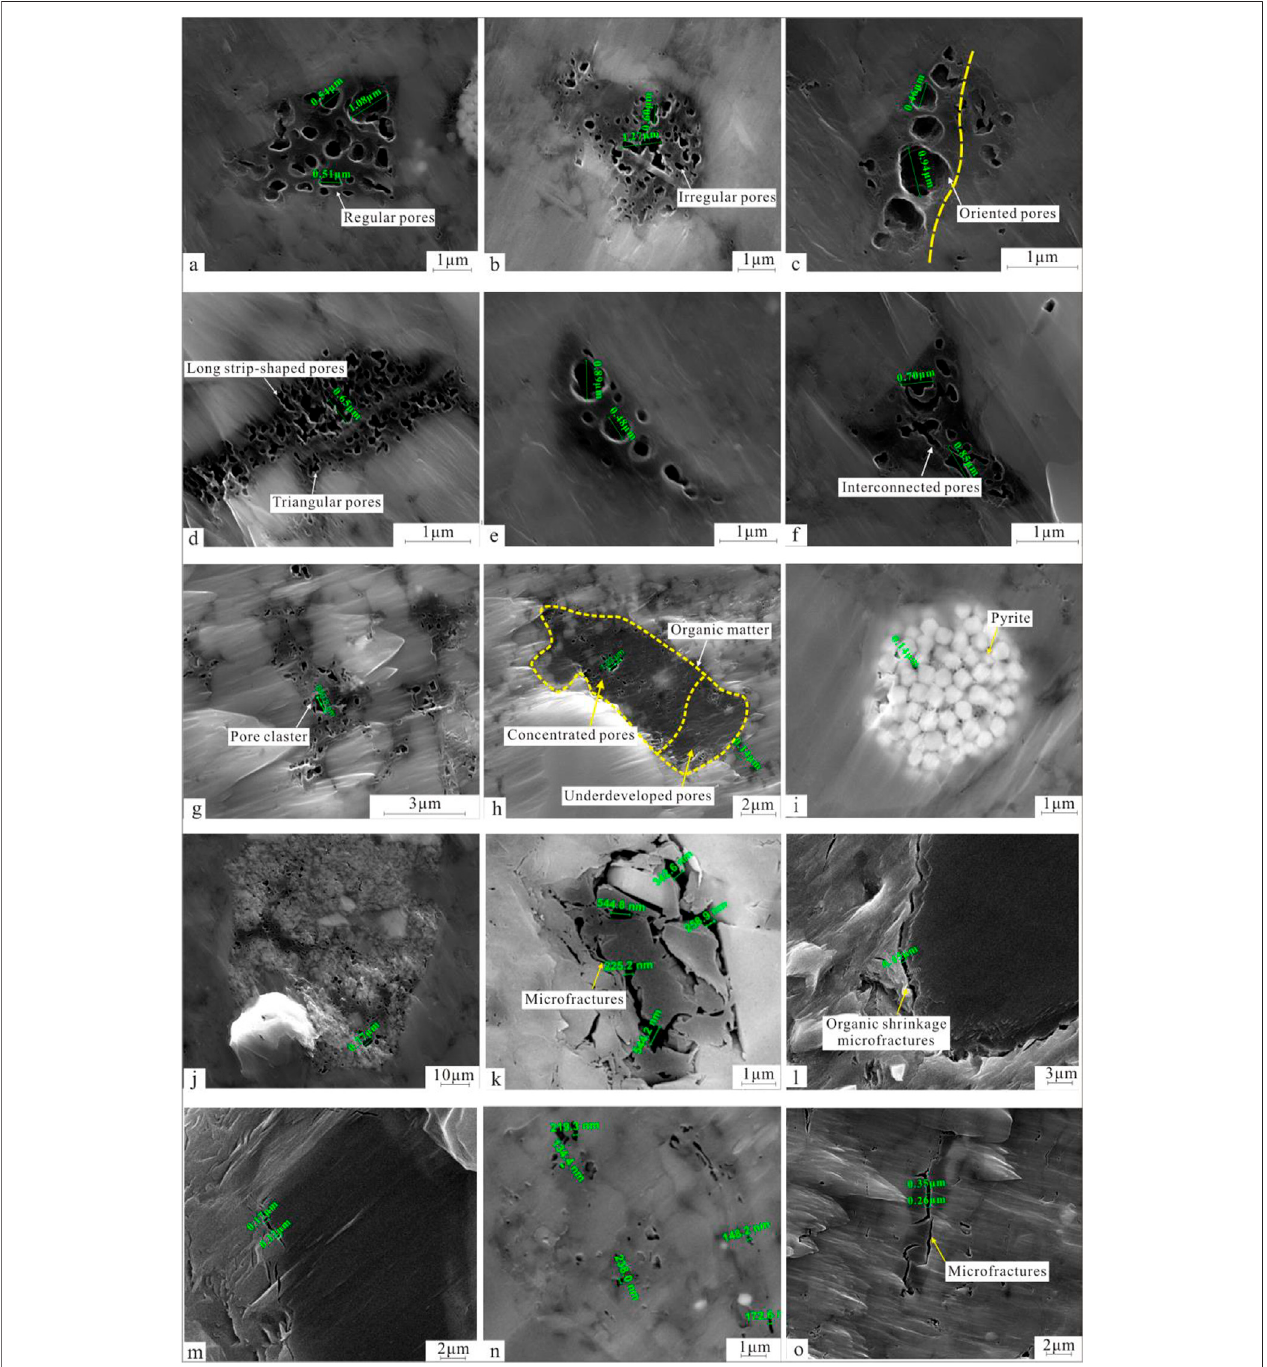
FIGURE 5 | Argon ion polishing scanning electron microscope images of shale samples from Oriente Basin, Bohai Bay Basin and Sichuan Basin. Notes: (A) Well Lc-1, 2,483 m, round and elliptical organic matter pores with good connectivity; (B) Well WF-1, 2,455 m, irregular and elliptical pores; (C) Well Lc-1, 2,483 m, organic poresdistributed in abeaded shape, with good orientation; (D) Well Lb-1, 2,483 m, triangular and long strip-shaped organic pores, theporesare disorderly distributed; (E) Well Lc-1, 2,483 m, fl ower-like distribution of organic matter pores; (F) Well Lc-1, 2,483 m, interconnected organic matter pores; (G) Well Lb-1, 2,483 m, pore clusters randomly distributed along the organic matter; (H) Well La-1, 2,480 m, different pore development levels on the same piece of organic matter; (I) Well WF-1, 2,455 m, symbiotic organic matter and pyrite accompanied by oval organic matter pores; (J) Well Lc-1, 2,483 m, organic pores developed at the boundary between organic matterandtitaniumdioxide; (K) WellBS5,4,761.55 m,organicmattermicrofractures; (L) WellY120, 3,507.2 m,organicshrinkagemicrofracturesdeveloped at the edge of organic matter; (M) Well Y120, 3,507.2 m, organic shrinkage microfractures; (N) Well BS5, 4,764.45 m, intra-organic pores and dissolution pores; (O) Well Y115, 4,004.1 m, matrix microfractures.